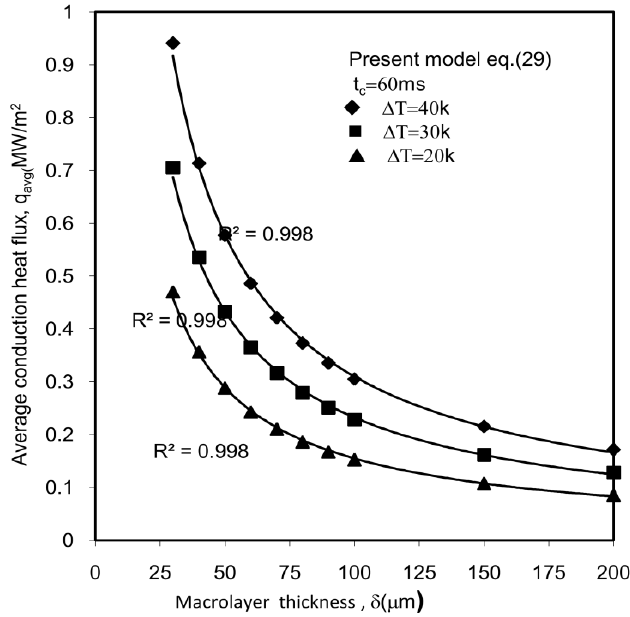
Figure 10. E ff ect of the macrolayer thickness on the average conduction heat flux for di ff erent superheats with t c = 60